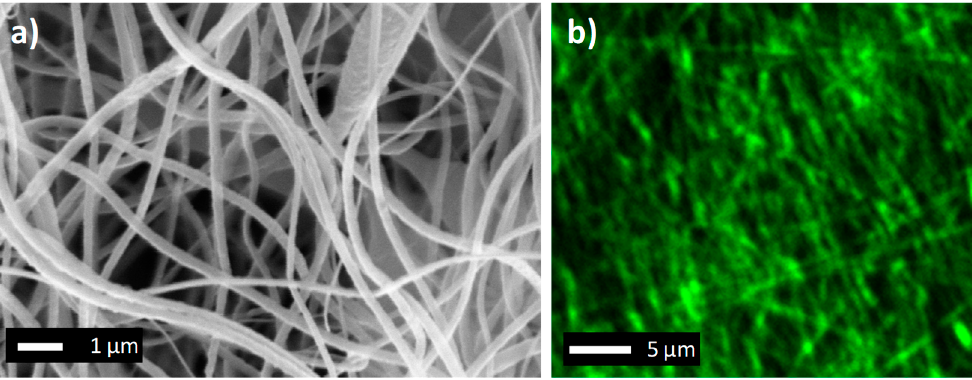
Figure 3. PVDF membrane: a ) SEM picture; b ) Confocal microscope picture.